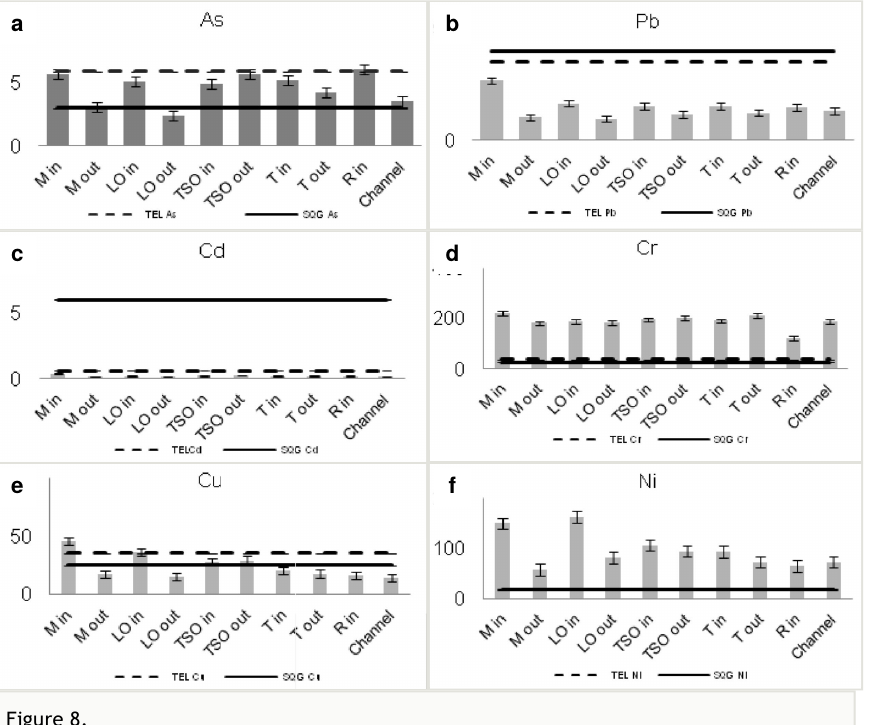
Heavy metals concentrations in the sediment from each station. The dashed line represents the TEL threshold. The continuous line represents the SQG threshold. Abbreviations correspond to: M: the stations of Mazoma lagoon, LO: the stations from Logarou lagoon, TSO: the stations from Tsopeli lagoon, T: the stations from Tsoukalio, R: the station from Rodia lagoon, Channel: the outer station of Rodia